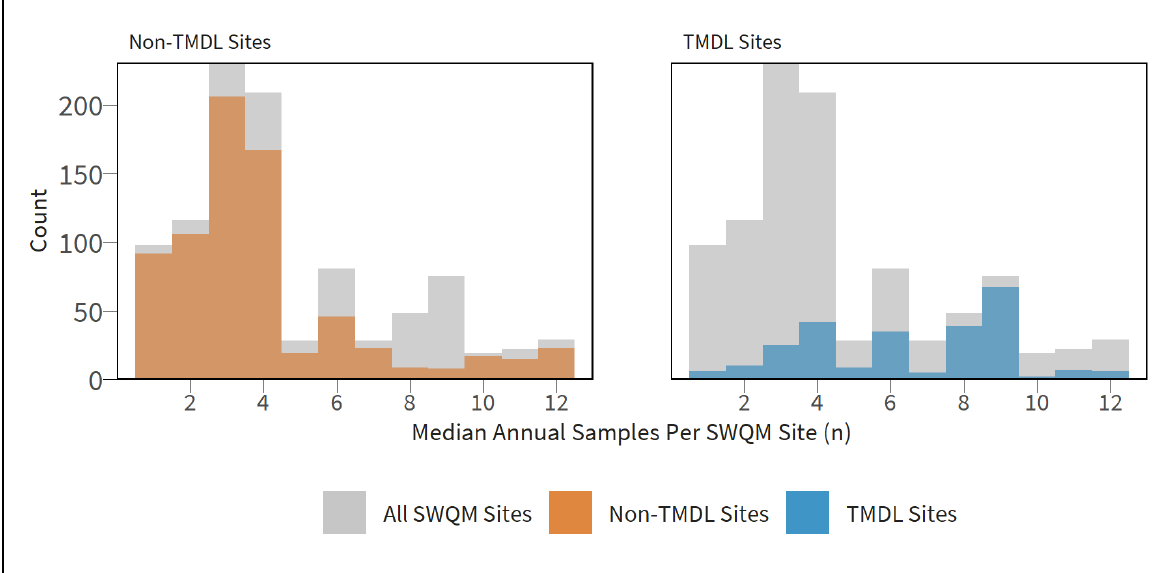
Figure 2. Histograms of annual E. coli sampling distribution for TMDL and non-TMDL SWQM sites across Texas (January 2012 through December 2019).